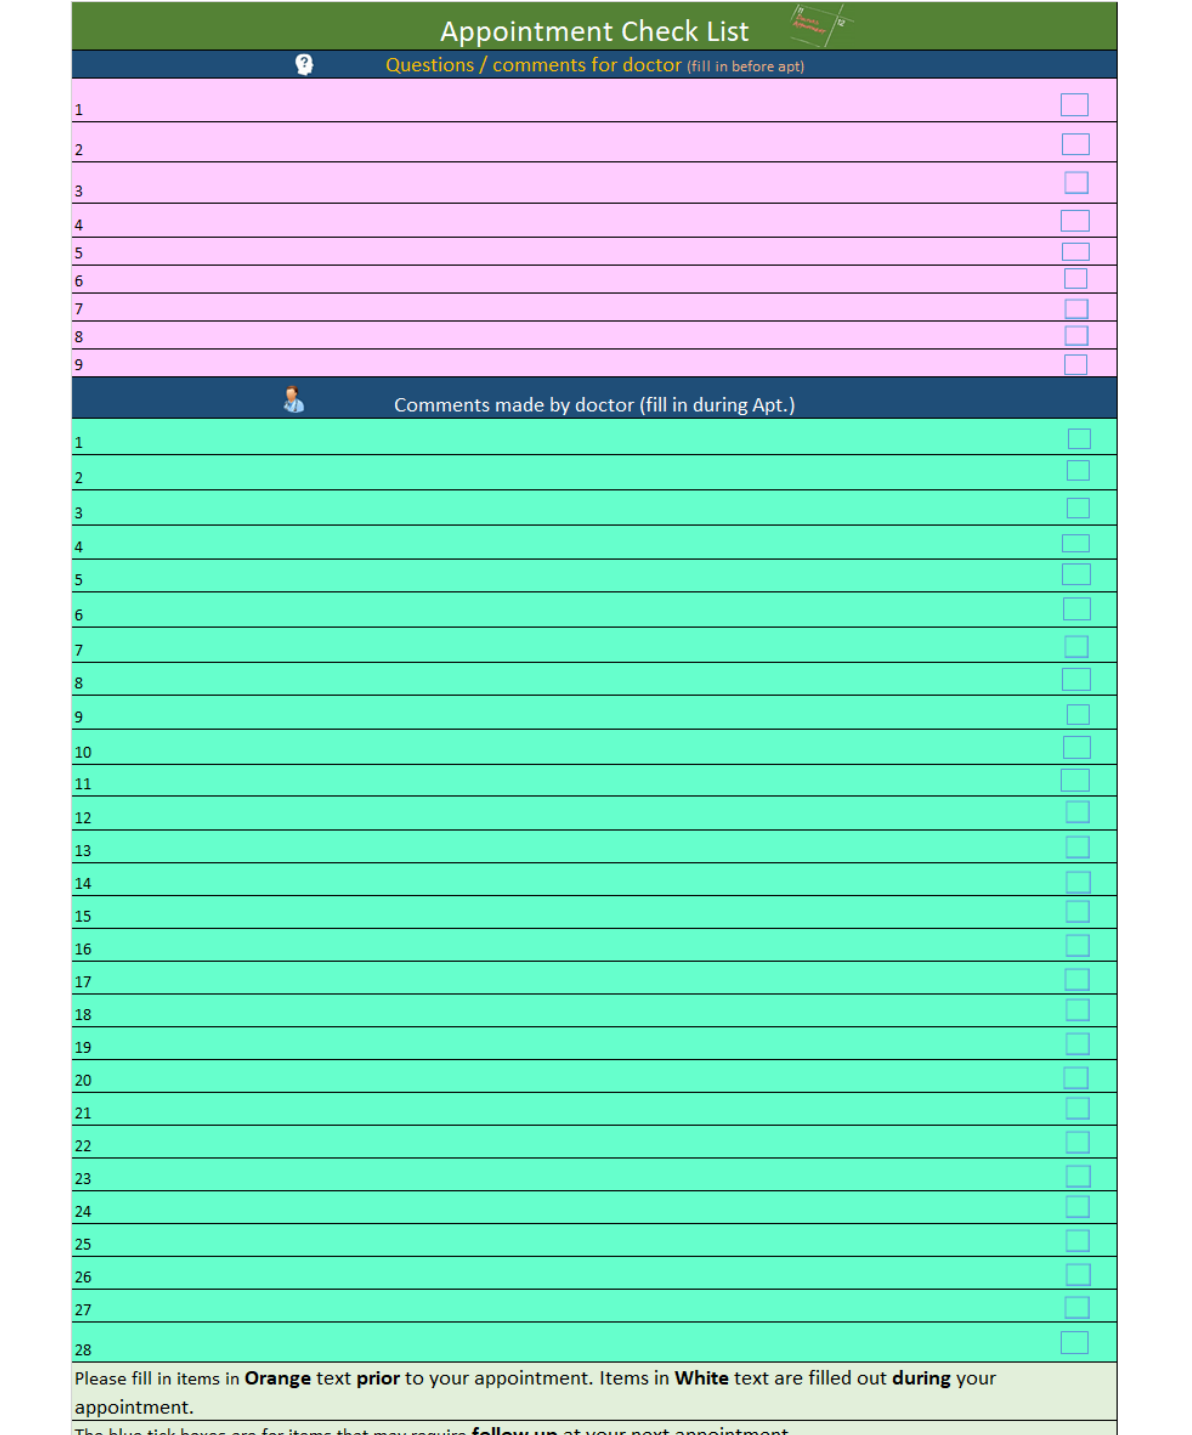
Figure 6. Version 3, part 2, of the